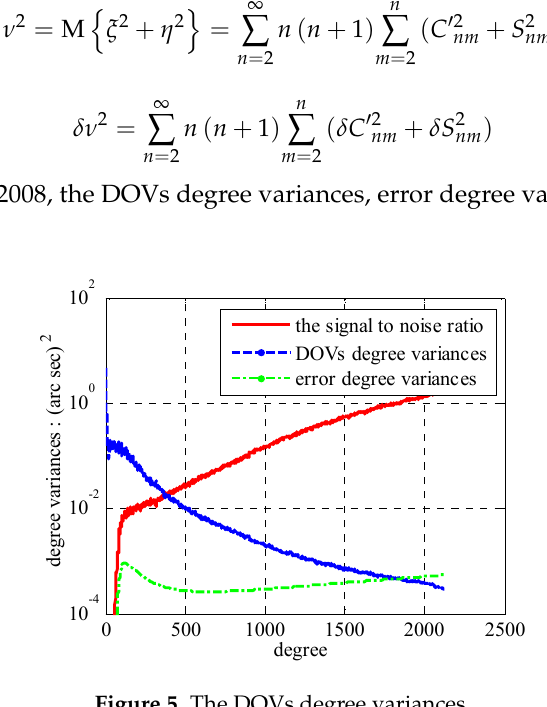
Figure 5. The DOVs degree variances.